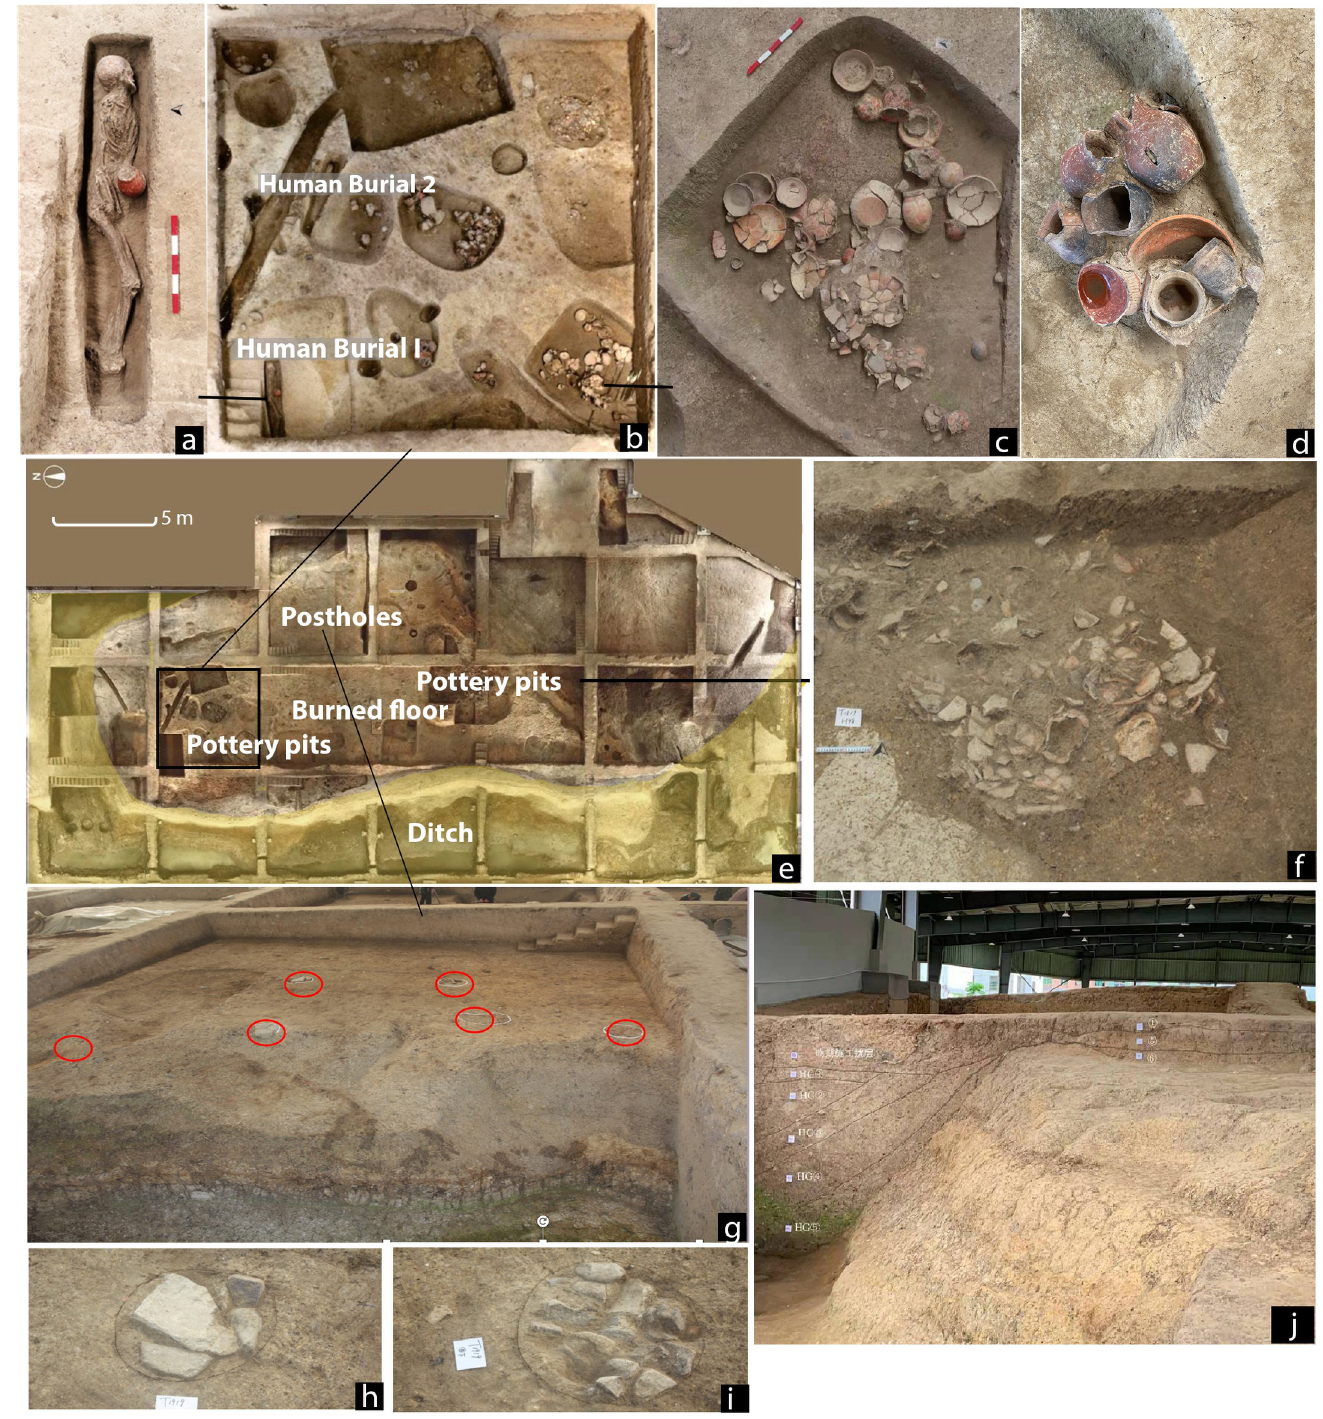
Fig 2. Archaeological features from Qiaotou platform mound. (a) Human burial 1(M44);b, The locations of human burials and associated pottery pits; (c) and (d) Painted pottery vessels suitable for serving foods and drinks; (e) A bird view photograph showing the location of the platform in relation to the ditch; (f) Pit H98 during excavation, which contained 50 complete pots; (g) A group of postholes from the eastern side of the platform; (h) and (i) Postholes with stone pillar bases; (j) The ditch (left) and platform (right) at Qiaotou.